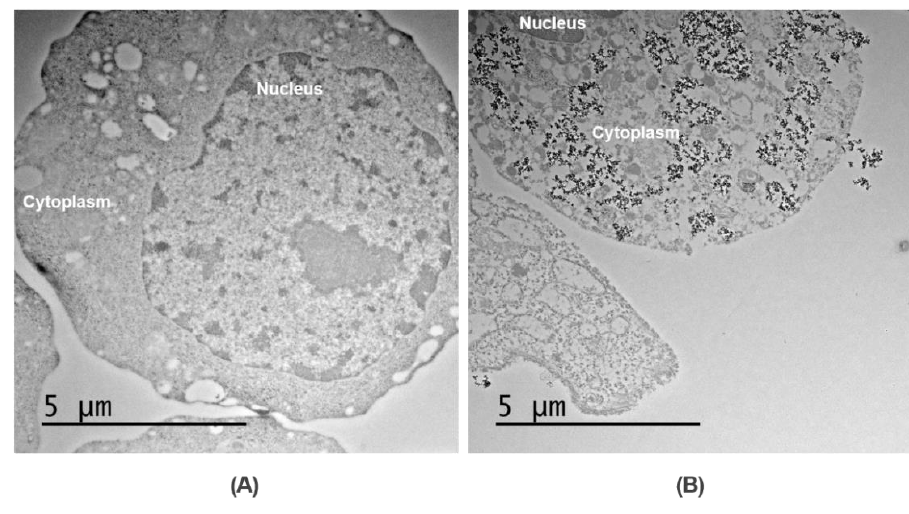
Figure 5. Bio-TEM image of a macrophage cell ( A ) and a Macbot ( B